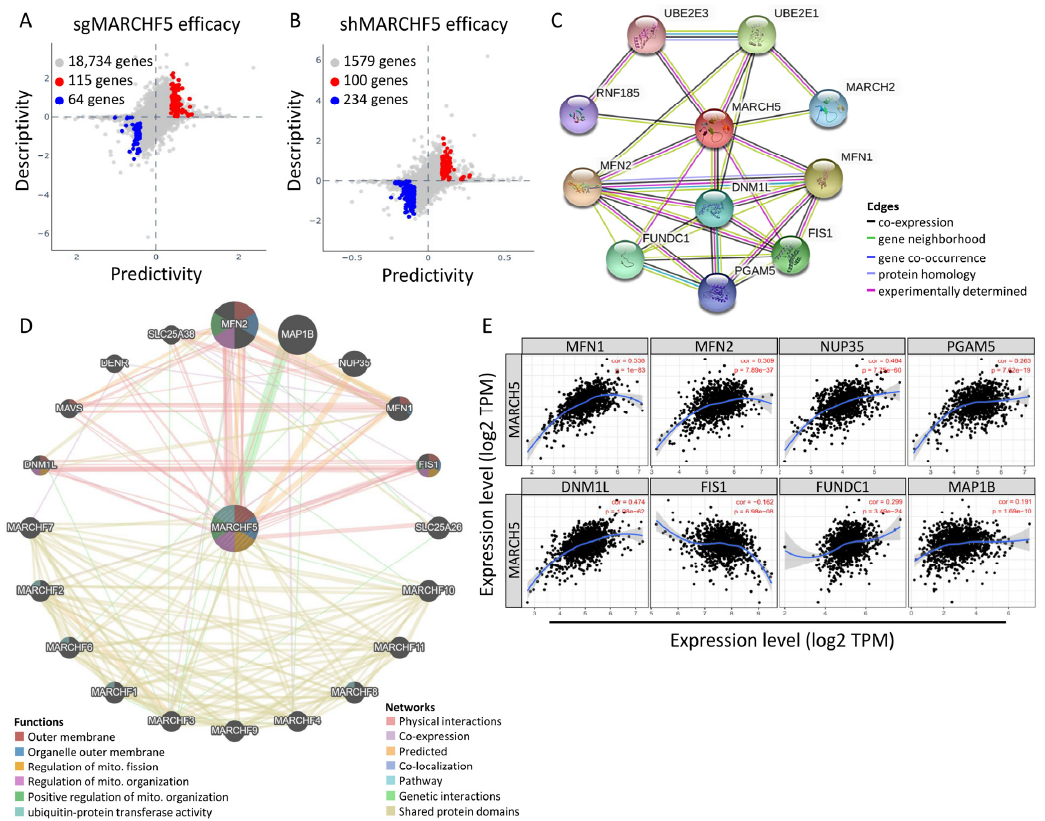
Figure 7. Intergenic correlations, co-expression network, and the biological functions of MARCH5. ( A , B ) Bidirectional predictive and descriptive analysis of gene expression in breast cancer cell lines. Predictability and descriptiveness between mRNA expression and sgRNA/shRNA efficacy are plotted. Hit genes showing positive or negative scores with p -values <0.01 for both predictive and descriptive aspects were selected. ( C ) PPI network constructed using the STRING database shows MARCH5 and the interacting proteins. The line thickness indicates strength of interaction between any two proteins. ( D ) GeneMANIA database analysis shows that MARCH5 interacts with mitochondrial dynamics proteins. ( E ) The association between MARCH5 and mitochondrial dynamics-related genes.